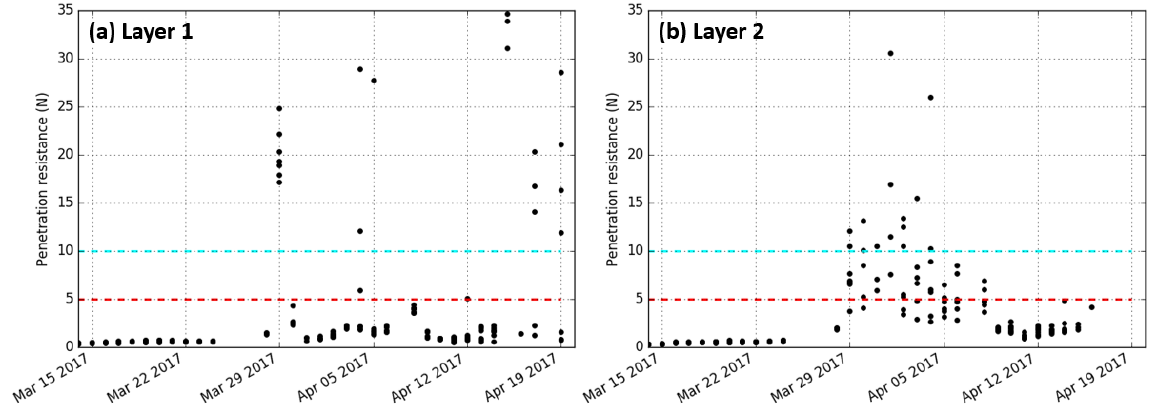
Figure 9. Evolution of the penetration resistance of (a) layer 1 and (b) layer 2, manually tracked in the SMP profiles, from 14 March to 19 April. Thresholds of 5 and 10N are indicated in red and cyan, respectively, accordingly to Fig. 7.